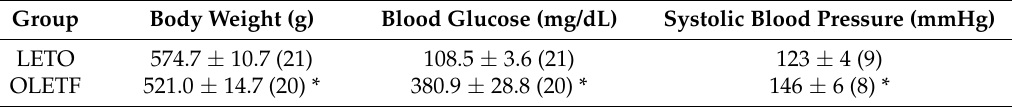
Table 1. General parameters.